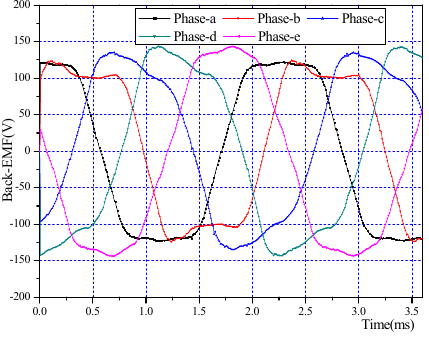
Figure 6. The load back EMF waveform under single ‐ phase open ‐ circuit fault ‐ tolerant conditions.